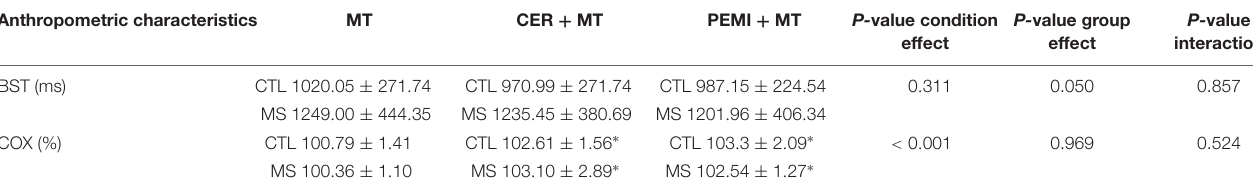
TABLE 2 | Bivalent shape test (BST) scores and cerebral oxygenation (COX) during the mental task (MT), control exercise recovery + mental task (CER + MT), and post-exercise muscle ischemia + mental task (PEMI + MT) tests for control (CTL, n = 14) and metabolic syndrome (MS, n = 13) groups. Anthropometric characteristics